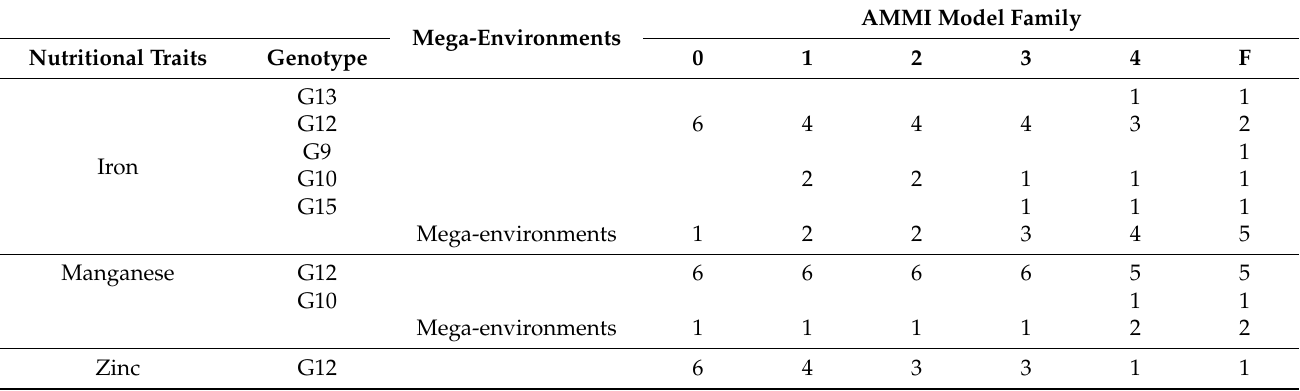
Table 4. Winning cowpea genotypes for nutritional composition and mega-environment delineation based on additive main effects and multiplicative interaction (AMMI) model